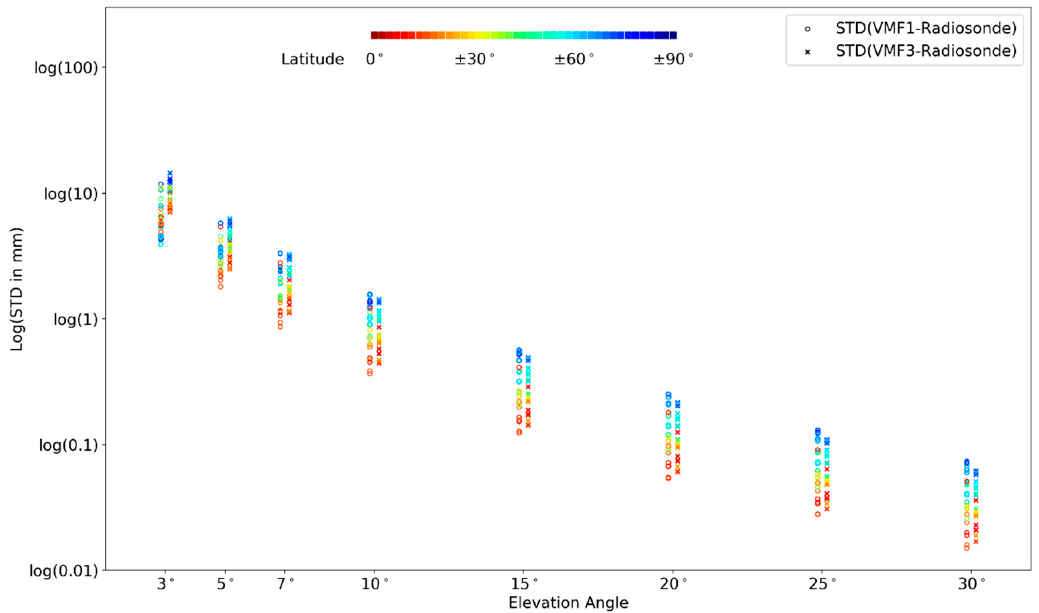
Figure 9. Standard deviations of the biases between the VMF3/VMF1 SHD estimates with respect to radiosonde + ISA76 SHD estimates by ray-tracing in mm, for the 28 stations of this study, over a 3-year period (1 January 2016 to 31 December 2018). The circle stands for the VMF1 case, and cross marks stand for the VMF3 case (the two cases are plotted with a small horizontal shift to avoid overlapping). The color bar indicates the station